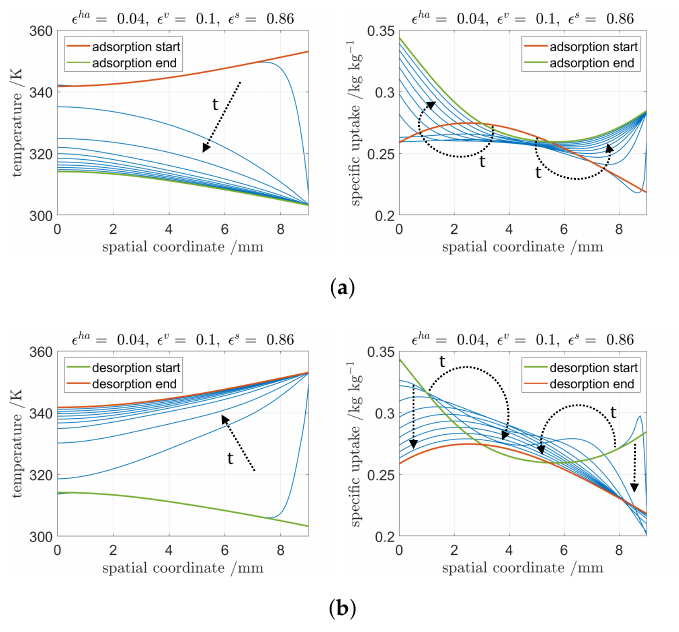
Figure 6. Spatial temperature and specific uptake profiles exemplary for a layer thickness ot 9 mm, cycle time of 200 s and a CDC-plate composition of (cid:101) ha = 0.04, (cid:101) v = 0.1 and (cid:101) s = 0.86. ( a ) Adsorption step: Spatial temperature and uptake profiles in the first half of the cycle time. ( b ) Desorption step: Spatial temperature and uptake profiles in the second half of the cycle time.